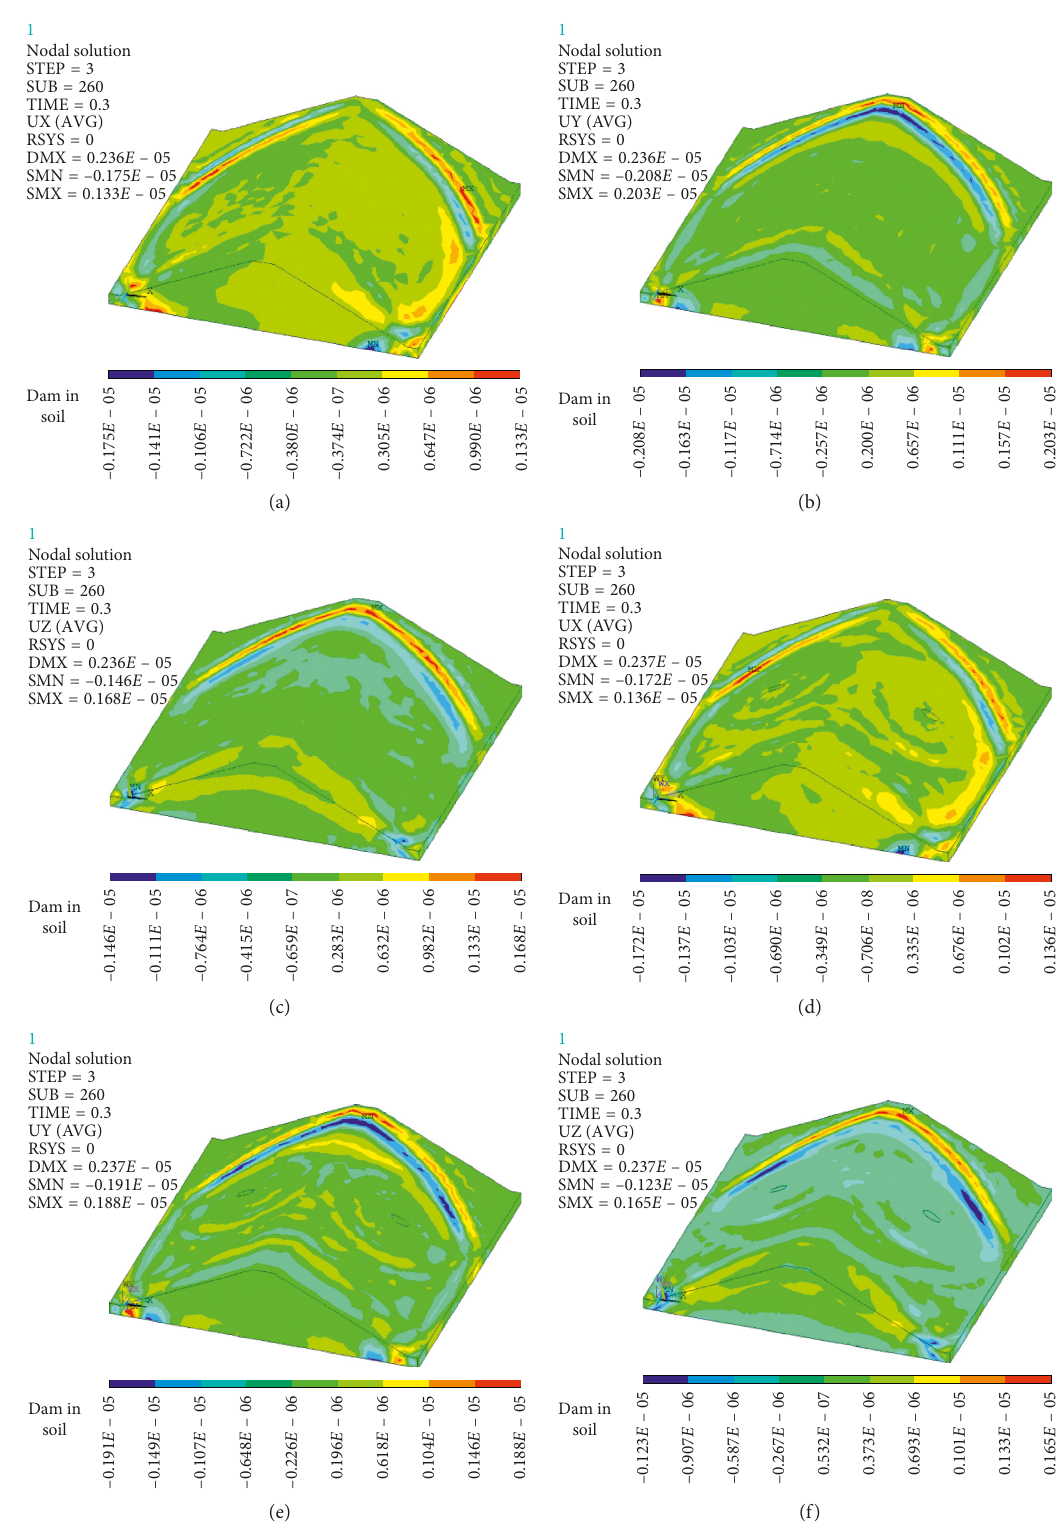
Figure 3: Three-dimensional wave field of the earth-rock dams with/without hidden hazards. (a) Displacement in x direction at 0.3 s in a case with no hazards. (b) Displacement in y direction at 0.3s in a case with no hazards. (c) Displacement in z direction at 0.3s in a case with no hazards. (d) Displacement in x direction at 0.3s in a case with hazards. (e) Displacement in y direction at 0.3s in a case with hazards. (f) Displacement in z direction at 0.3s in a case with